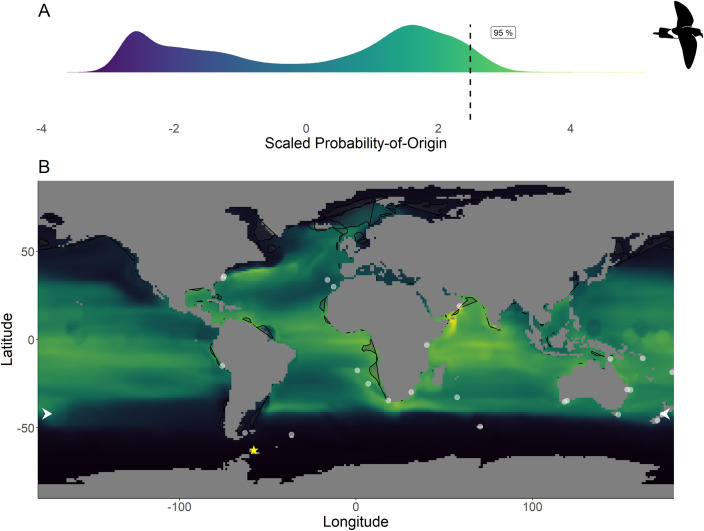
Scaled probability-of-origin map based on δ13C and δ18O for the black-bellied storm-petrel.(A) Scaled probability-of-origin value distribution; (B) scaled probability-of-origin map. Scaled probability-of-origin values are shown on a relative high (yellow)–low (black) gradient in both the density plot and map. The 95% quantile of the scaled probability-of-origin values is shown with the dashed line. Shaded contours show high chlorophyll-a concentration areas (upper 95% of the data), and white dots show observation locations [88, 89]. The white arrows at the edge of the plot show the predicted moulting latitude based on the equation from Quillfeldt et al. 2005([76]; Table 4). The yellow star indicates the location of the breeding colony where birds were sampled.